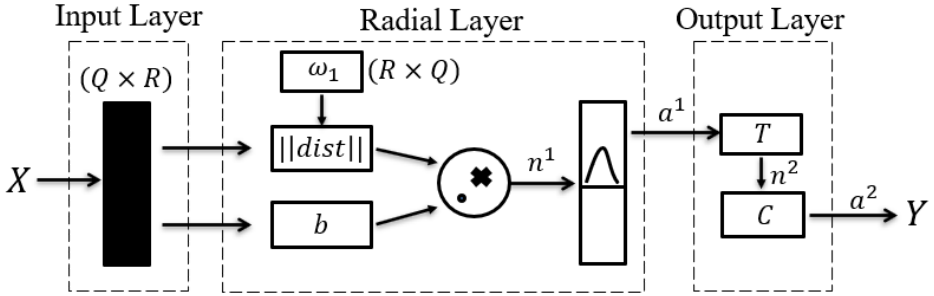
Figure 7. PNN classification model diagram.